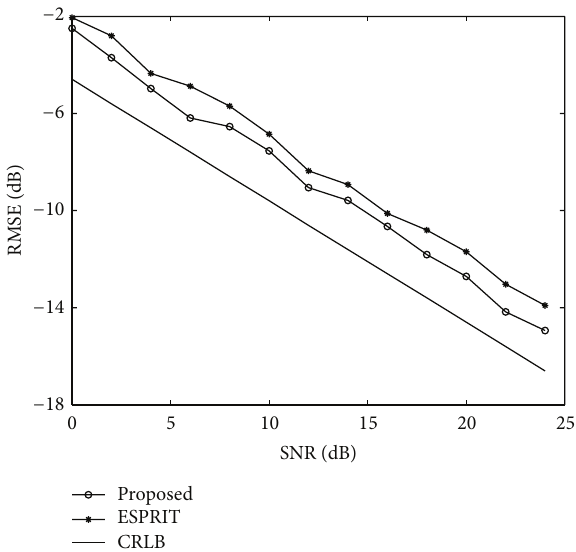
Figure 4: Root mean square error for 𝜙 2 versus